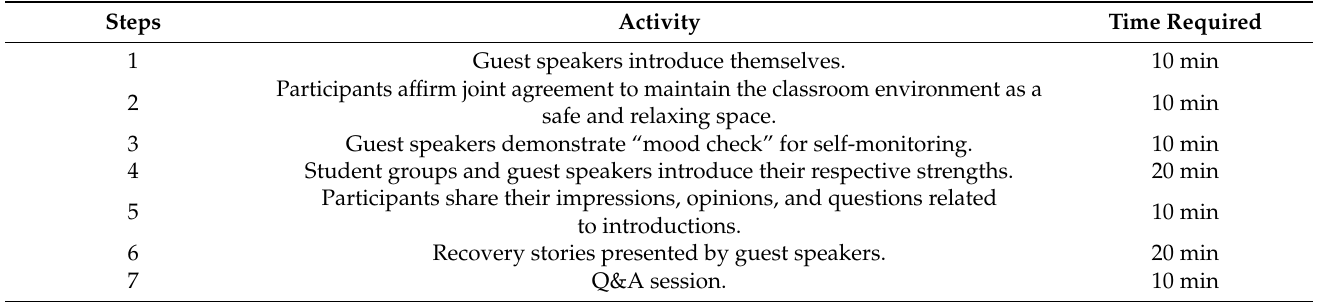
Table 1. Lesson plan of the educational